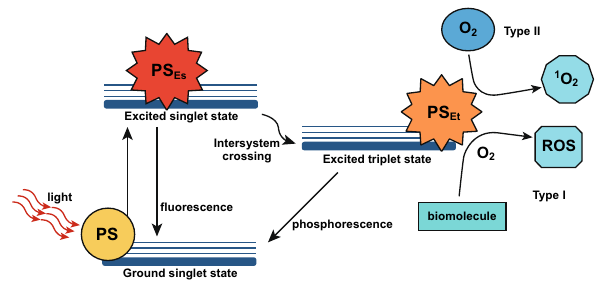
Fig. 8 Jablonski’s diagram illustrating PDT mechanism. The pho- tosensitizer (PS) is excited from a ground state to an excited single (PS Es ) and then a triple (PS Et ) state, in which it could react in two ways (Type I and II). Reprinted under a Creative Common Licence CC-BY 4.0. Copyright 2020 from Ref.